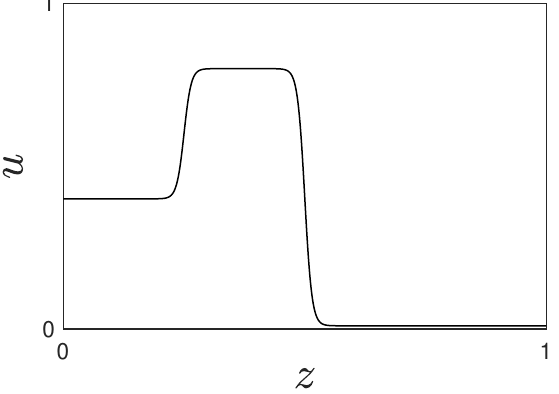
Figure 1. Initial condition u ( z ,0 ) for problem (55) with a single overshoot. Numerical solutions for problem (55) with initial data as shown in Figure 1 were studied in [6–8]. For this simple class of processes with a single saturation overshoot, the saturation history at positions z > z a has length N ( z ) = 0, while N ( z ) = 1 for z ≤ z a . For any time t with 0 < t < T , there is a fixed graph G im describing the flow process at each z ∈ I ( t ) in terms of a flow function f im ( u ; { u ∗ 0 } ) parametrized by the saturation value u ∗ 0 = u ( z , 0 ) at t 0 = 0. Furthermore, there is a fixed graph G dr describing the flow process at each z ∈ D ( t ) in terms of a flow function f dr ( u ; { u ∗ 1 } ) parametrized by the saturation value u ∗ 1 = u ( z , t 1 ) at the time instant t 1 ( z ) when the flow process switched from imbibition to drainage. For a single overshoot, the value of u ∗ 1 is, of course, u ∗ z = max z ∈ Ω u ( z , 0 ) . By continuity of the hysteresis model and by continuity of the graph G = G im ∪ G dr , the flux is continous for all z ∈ P ( t ) with 0 < t < T . In this situation,